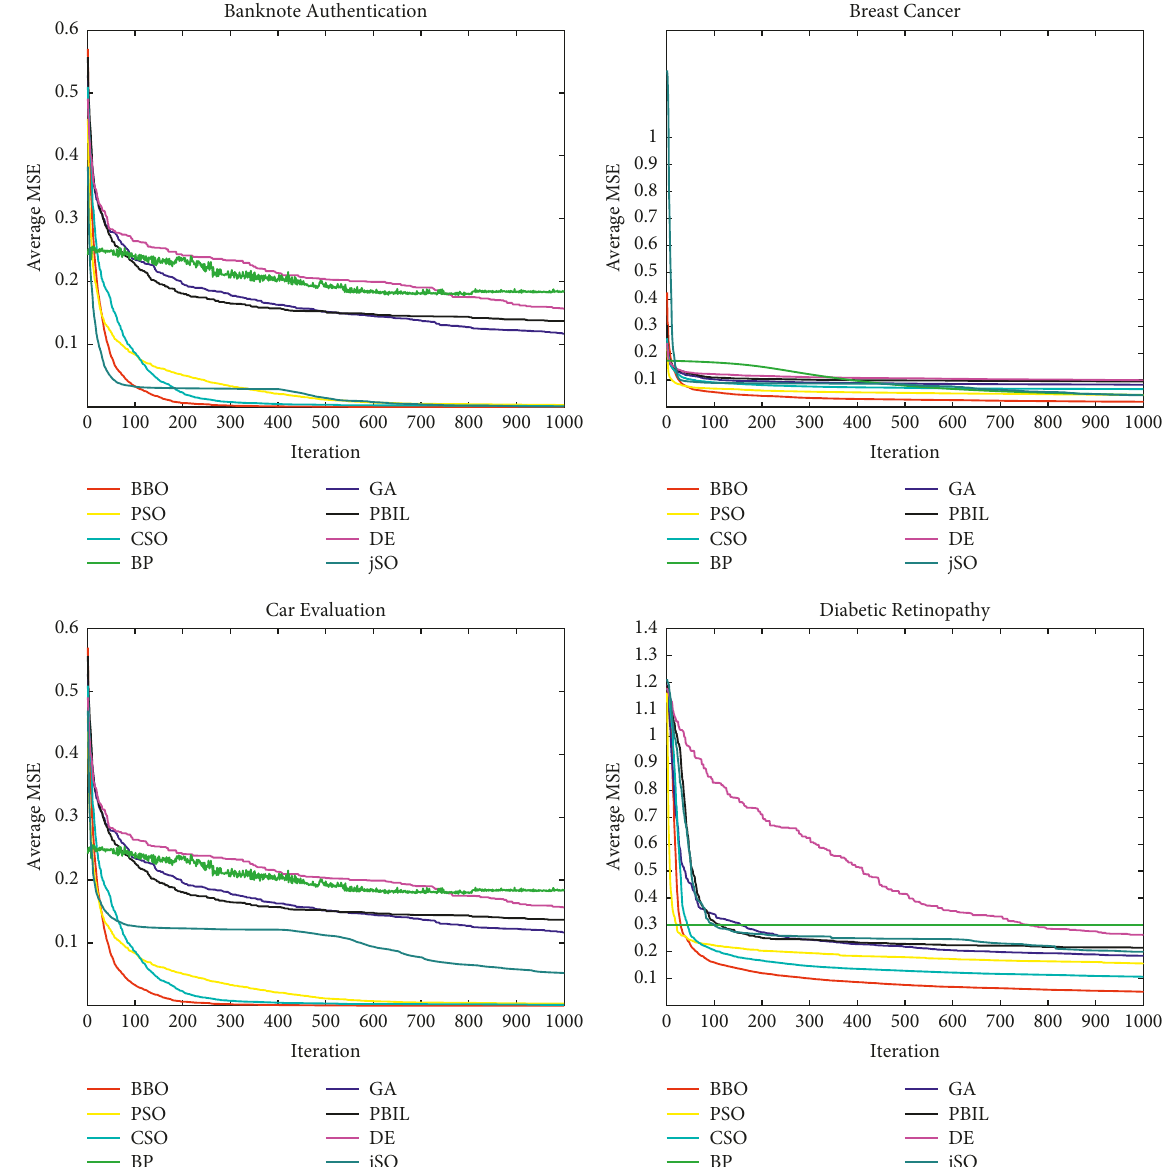
Figure 3: Convergence graphs of the learning algorithms for the datasets of banknote authentication, breast cancer, car evaluation, and diabetic retinopathy,